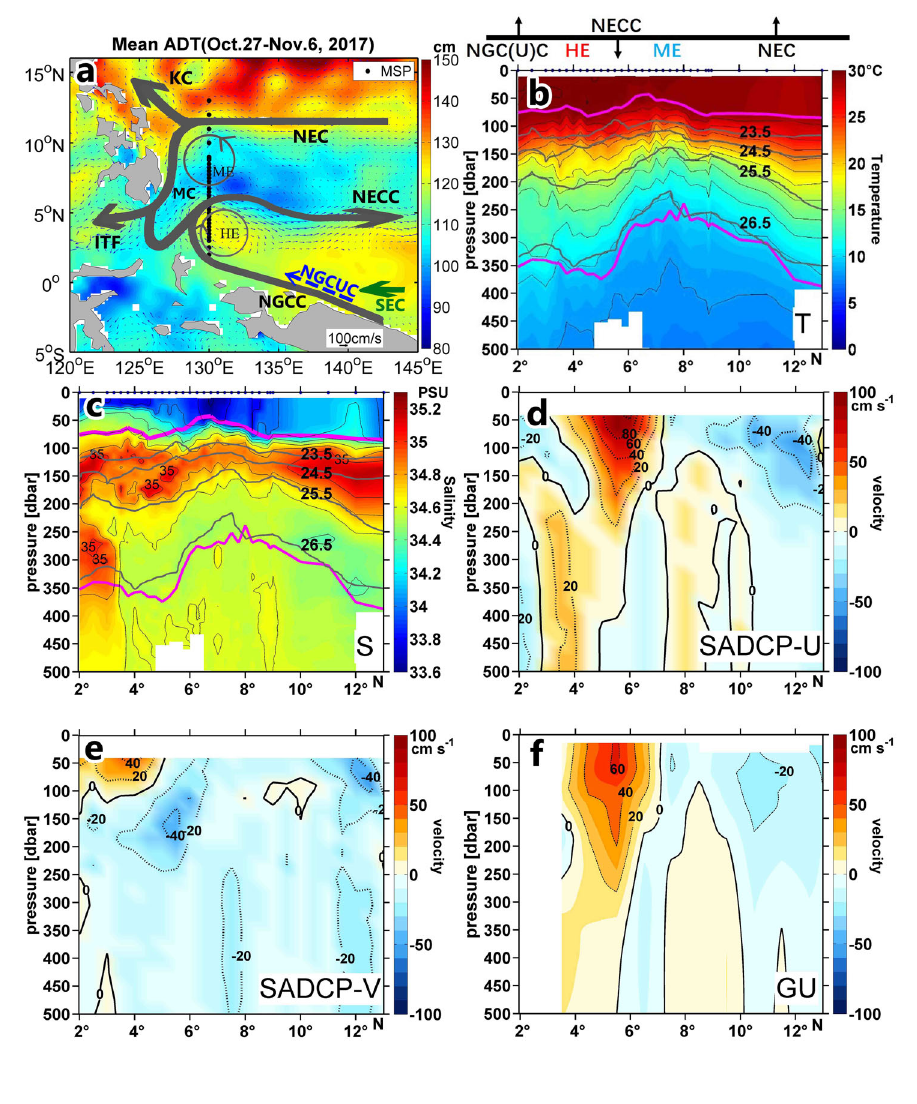
Fig. 1 Map of the study region and upper-ocean vertical structure during the 2017 cruise. a Schematic of major currents in the tropical western Paci fi c Ocean. NEC, North Equatorial Current; KC, Kuroshio Current; MC, Mindanao Current; NECC, North Equatorial Counter Current; NGCC, New Guinea Coastal Current; SEC, South Equatorial Current; ME, Mindanao Eddy; HE, Halmahera Eddy; ITF, Indonesian Through fl ow; NGCUC, New Guinea Coastal Undercurrent. The black dots indicate locations of microstructure pro fi les, and color shading shows the absolute dynamic topography (ADT) with the surface absolute geostrophic velocity (arrows) averaged between October 27 to November 6 in 2017 from altimetry (Supplementary Notes (2)). b , c Latitude-depth sections of temperature (T;°C)/salinity (S;PSU) measured by the microstructure pro fi ler (MSP) along 130°E section, thick gray lines are isopycnals; thick purple lines mark the upper and lower boundary of the thermocline (see Methods); black dots in the top axis are locations of MSP measurements. d , e Latitude-depth sections of zonal (U)/meridional (V) velocities (cm s − 1 ) measured by Shipboard Acoustic Doppler Current Pro fi ler (SADCP) along 130°E section. f Zonal geostrophic velocity (GU) calculated from the synchronous full-depth CTD measurements. COMMUNICATIONS EARTH & ENVIRONMENT| (2022) 3:28